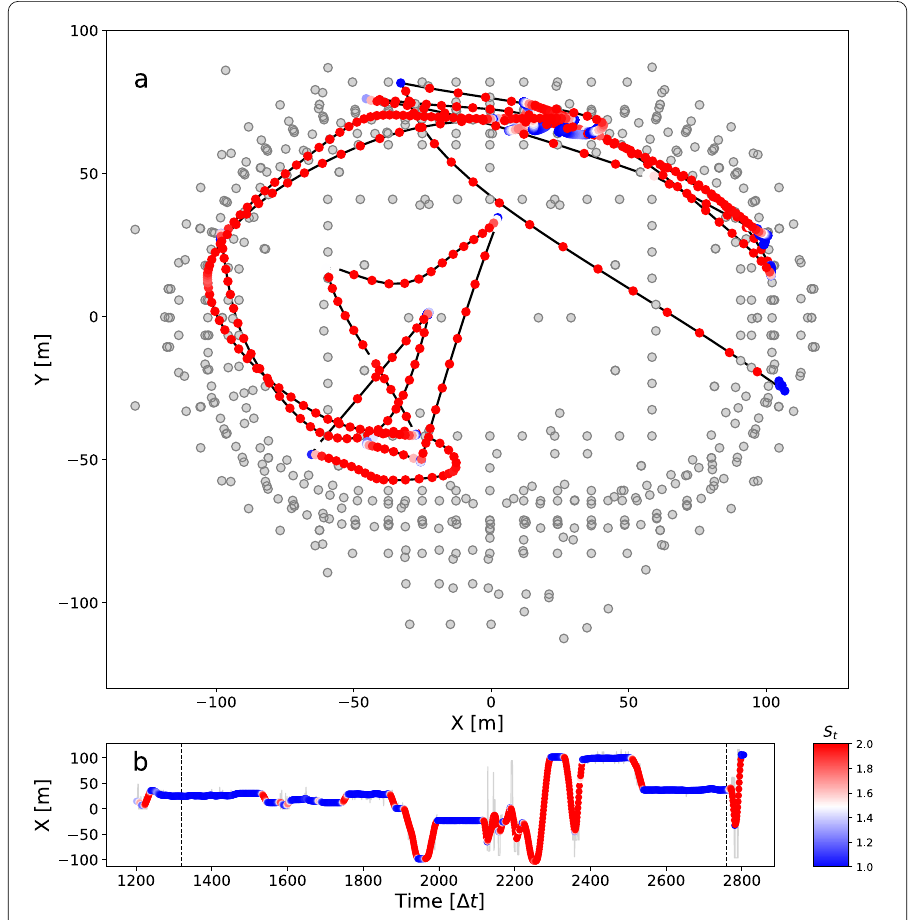
Figure 7 ( a ) Example of inferred locations and behavioural states by the DCRWS, of an example movement track during the Armin van Buuren dance event (same as Figs. 2 and 4). Colours represent posterior means of behavioural state estimates, where red is the moving state, and blue is the non-moving state. ( b ) Inferred locations and behavioural states shown in the x -coordinate time series (unit = (cid:2) t = 10 s). Dotted vertical lines indicate start and end times of the DJ show